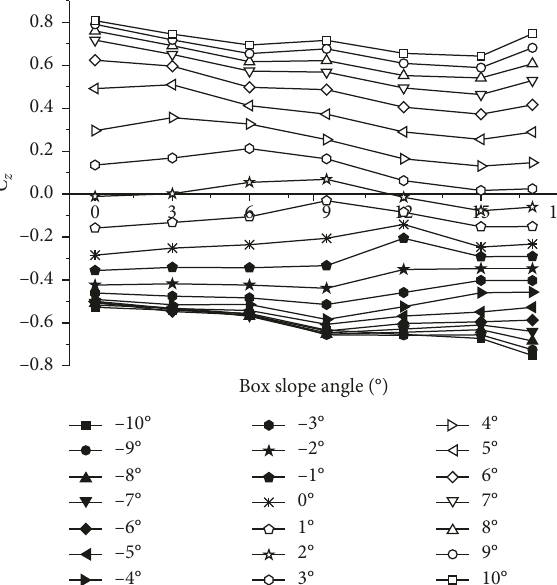
Figure 15: C z vs. box slope angle for various AOA.